Question: Give a one-sentence summary of this figure.
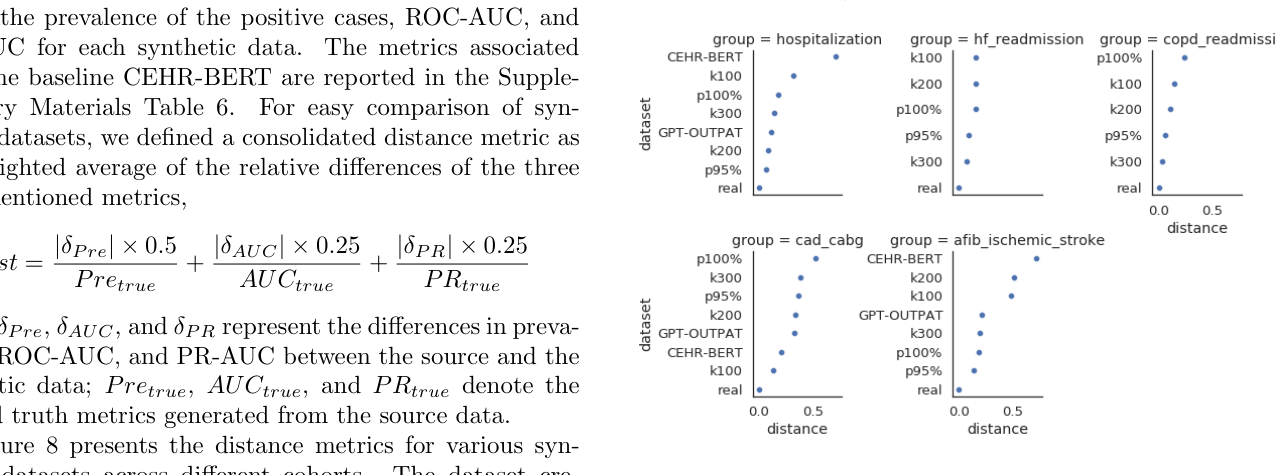
Answer: The consolidated distance metrics for different syn- thetic datasets stratified by cohort. GPT-Vanilla and CEHR- BERT were omitted as the cohorts couldn’t be constructed due to the loss of temporal information. GPT-OUTPAT was omitted from HF readmission and COPD readmission as the cohorts for the same reason.